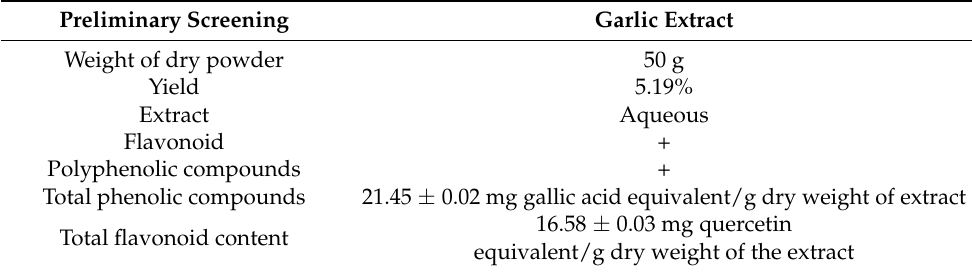
Table 1. Secondary metabolites in garlic.